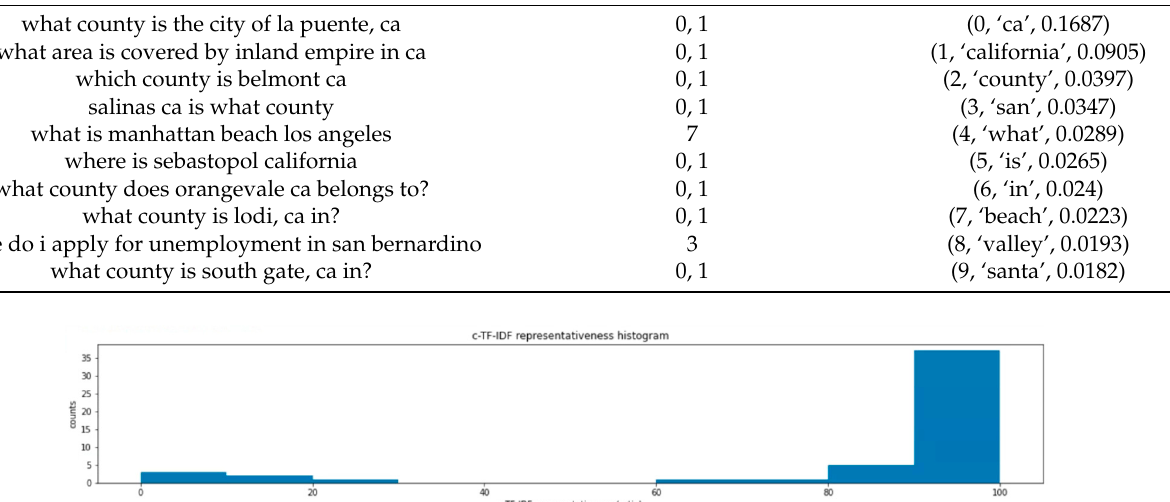
Table 12. Manual annotation example for topics 2, 3 regarding c-TF-IDF representativeness. All the